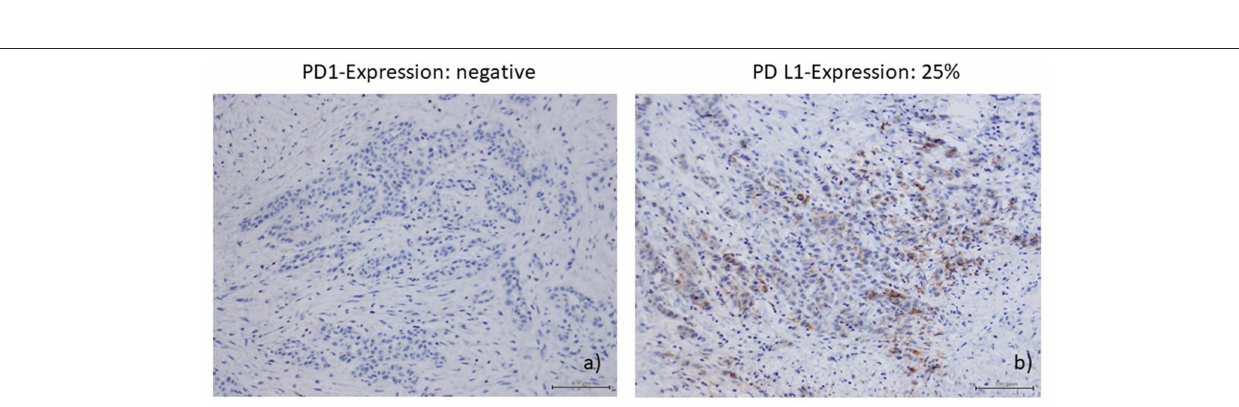
FIGURE 2 | (a) PDl-expression (Autostainer Benchmark Ultra; Ventana, antibodies: PDl-Clone NAT105, Abeam, UK); (b) PD-Ll-expression (PD-Ll-Clone 22C3, Dako,